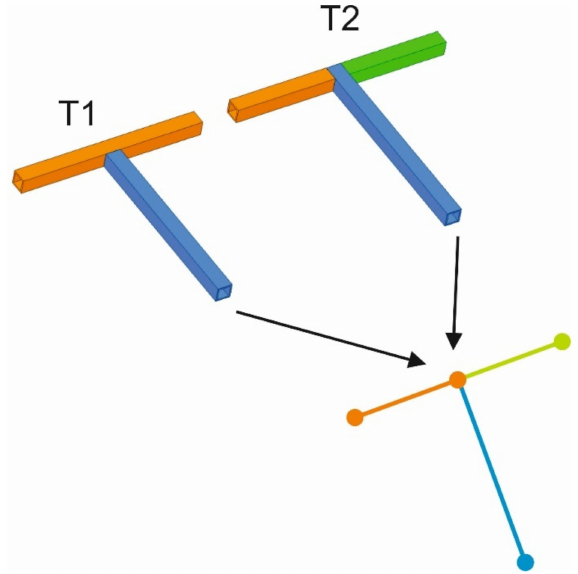
Figure 1. T-junctions equivalent beam type element model.